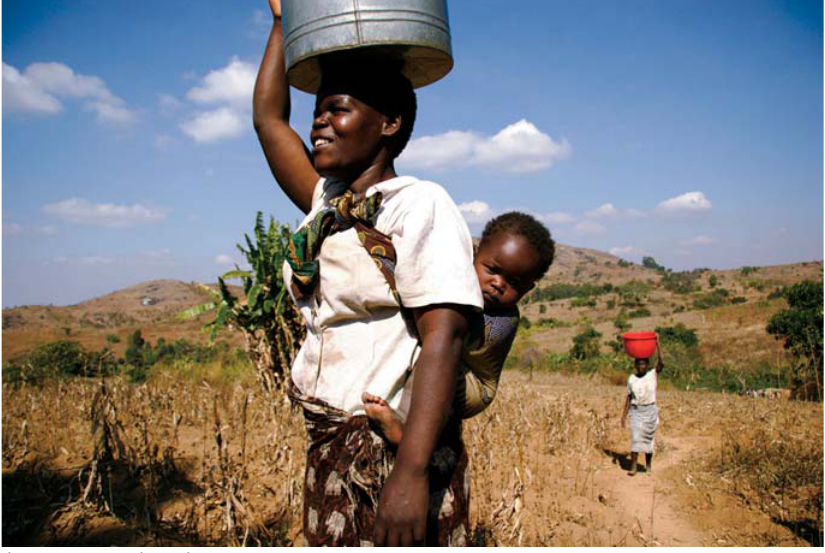
Figure 1. The Millennium Villages Project Photo: Yoshi Shimizu/International Federation of Red Cross and Red Crescent Societies